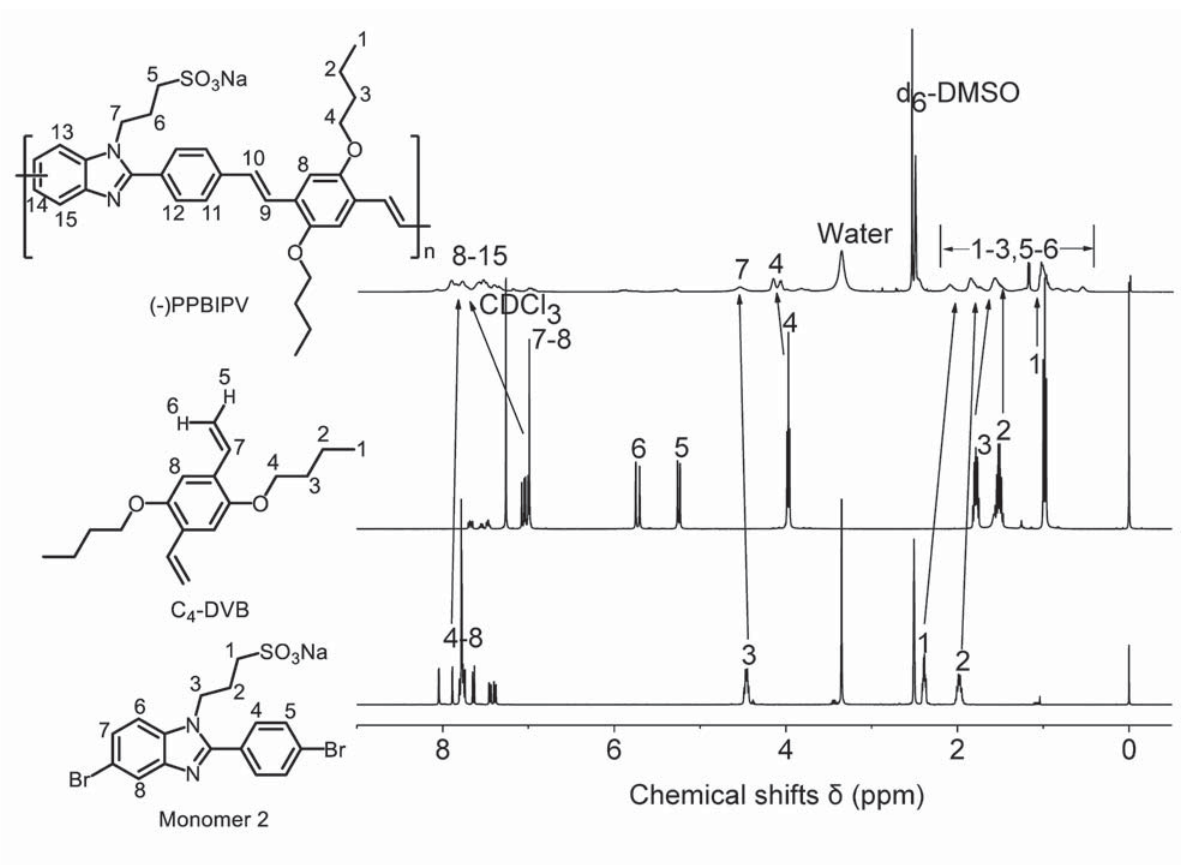
Figure 2: 1 H NMR spectra of monomer 2, C4-DVB and